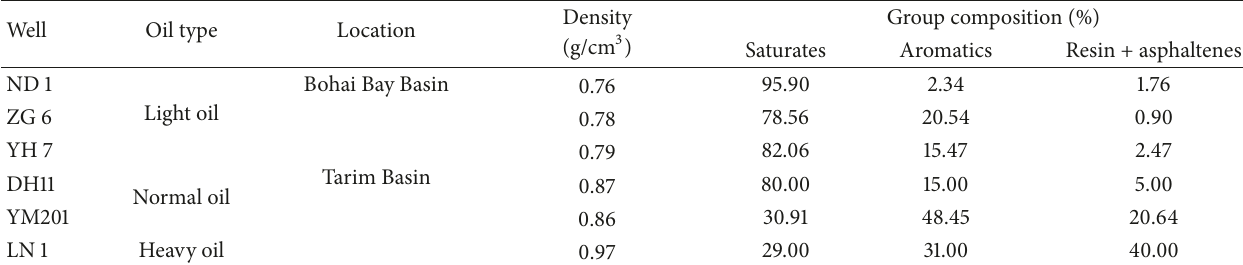
Table 2: The physical characteristics and geochemical compositions of oil